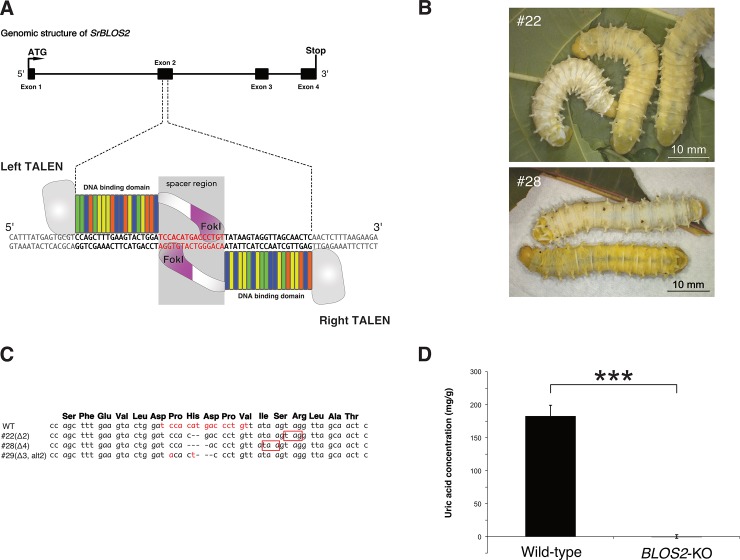
Characterization of transcription activator-like effector nuclease (TALEN)-generated Samia ricini biogenesis of lysosome-related organelles complex 1, subunit 2 knockout (SrBLOS2KO) mutants.(A) Schematic presentation of the spacer and binding sequences of TALEN targeting SrBLOS2. (B) Larval phenotype of SrBLOS2KO individuals. The upper panel shows larvae from strain #22. A wild-type larva is shown on the left, and two translucent individuals are presented on the right. The lower panel shows larvae from strain #28. A wild-type larva is presented on the top, and one translucent individual is shown on the bottom. (C) Mutations introduced in three SrBLOS2KO strains. The spacer sequence is shown in red. Premature stop codons generated by frame shift are highlighted with red squares. The deduced amino acid sequence of wild-type SrBLOS2 is shown on the top. (D) Comparison of uric acid concentrations in the integument of S. ricini wild-type and strain #22 larvae. Data are shown as the mean + standard error. n = 3. ***p < 0.001 by Student’s t-test.